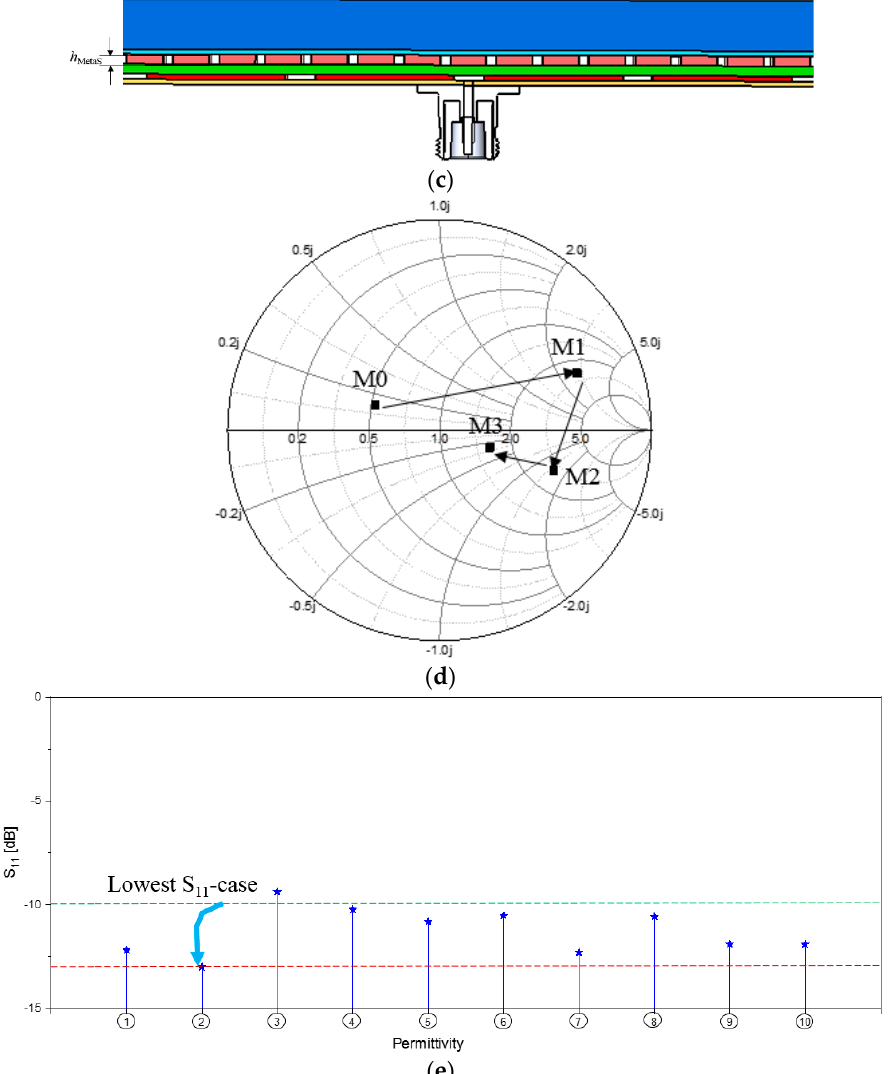
Figure 8. The input impedance of the sensor with a novel meta-surface ( a ) The unit − cell and its parametric study. ( b ) Meta-surface sandwiched by the COP film and back − cover. ( c ) Side − view. ( d ) Trace reaching the impedance matching. ( e ) Best guess is found as the permittivity of the COP film.